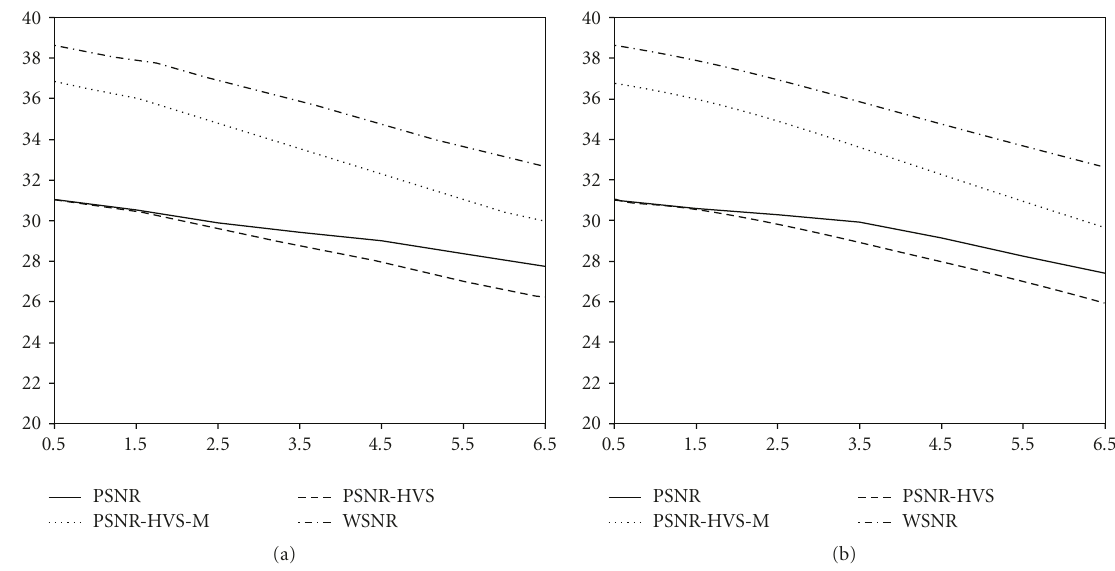
Figure 6: Dependencies of metrics on b for the image Baboon for the coders AGU (a) and ADCTC (b), σ 2 = 50.